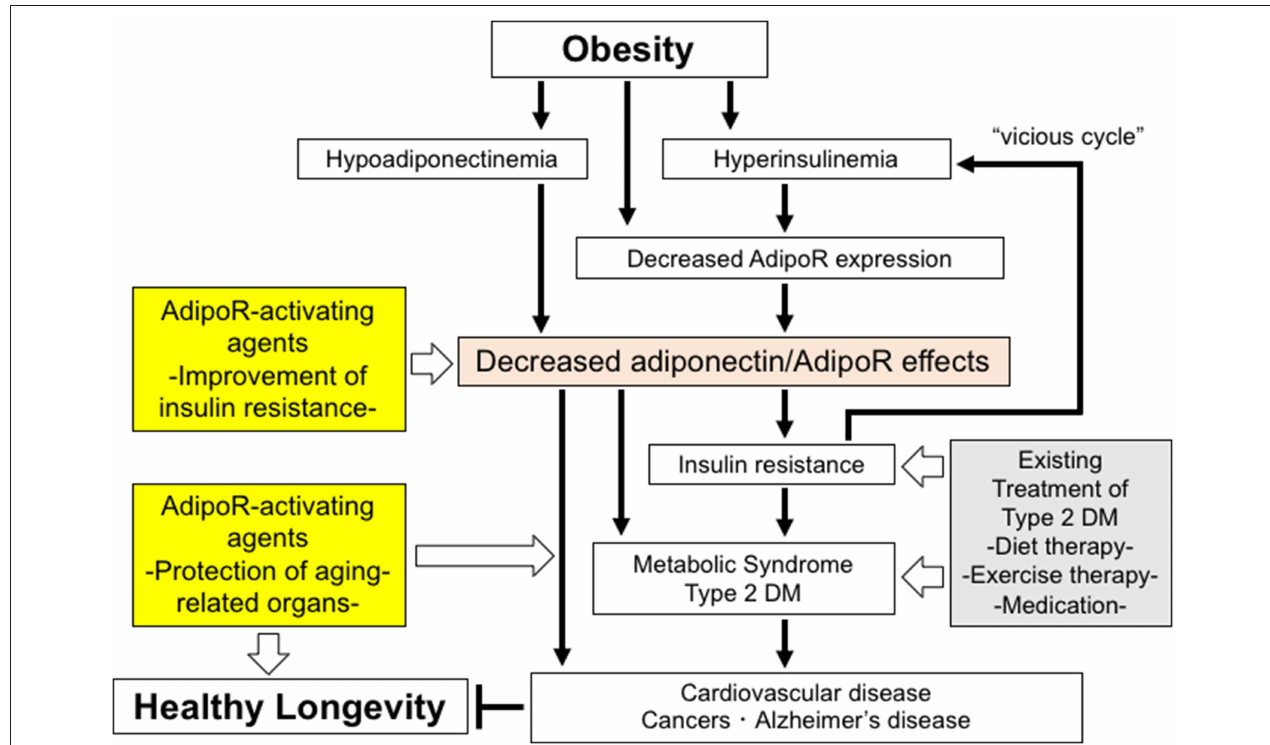
FIGURE 1 | The roles of decreased adiponectin/AdipoR effects in obesity-related diseases and potential strategies to increase the effects of AdipoR. Decreased adiponectin/AdipoR effects play causal roles in obesity-related diseases. Increased activation of AdipoR pathways may have beneficial effects on healthy longevity and obesity-related diseases, such as metabolic syndrome, type 2 diabetes, cardiovascular diseases, cancers, and Alzheimer’s